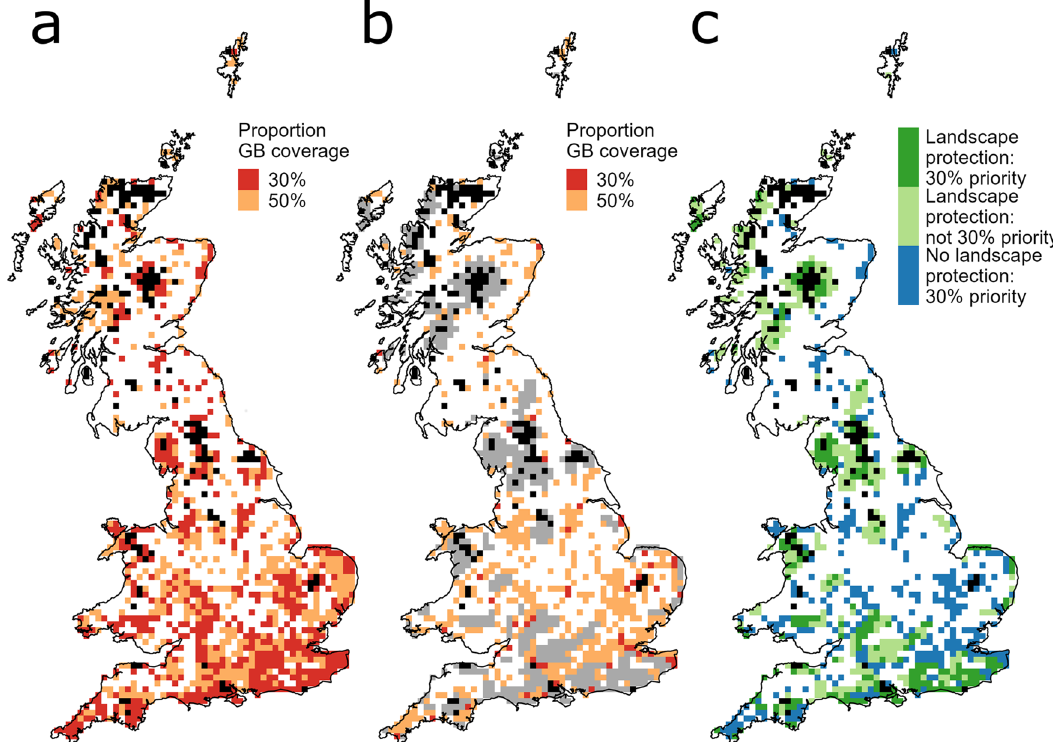
Fig. 1 Spatial priorities for additional area-based conservation to meet 30by30 coverage targets within Britain. a Scenario 1: prioritisation constrained only by the inclusion of current biodiversity protected sites. b Scenario 2: constrained by maintaining both biodiversity and landscape protection sites, as suggested by the 30by30 announcement. c Overlap between top 30% priority cells for biodiversity from scenario 1 and current protected landscapes. Cells already protected for biodiversity are shaded black (which are included as part of the ‘ top 30% in both scenarios). For panels ( a ) and ( b ), top 30% priority cells are shaded red, top 50% orange, and landscape protection cells are grey. In panel ( c ), priority cells for biodiversity are dark green if in a landscape protection cell and dark blue if outside a landscape protection cell; light green shows those landscape protected cells that are not a priority for biodiversity